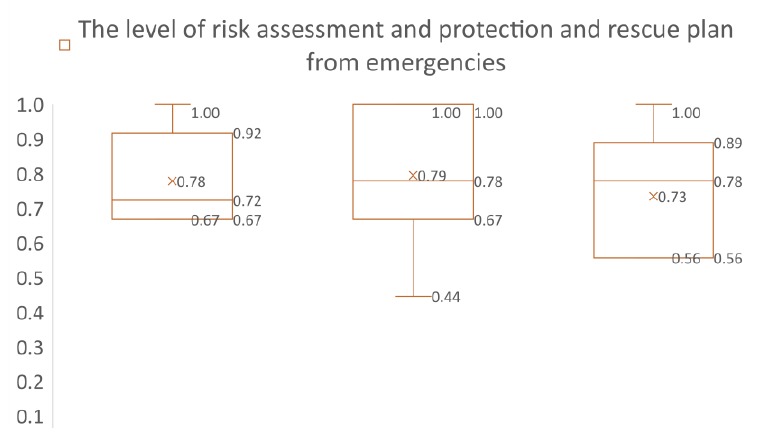
Figure 1: The Level of Risk Assessment and Development of Protection and Rescue Plans Summarised for Three Regions of Vojvodina (Source: Authors’